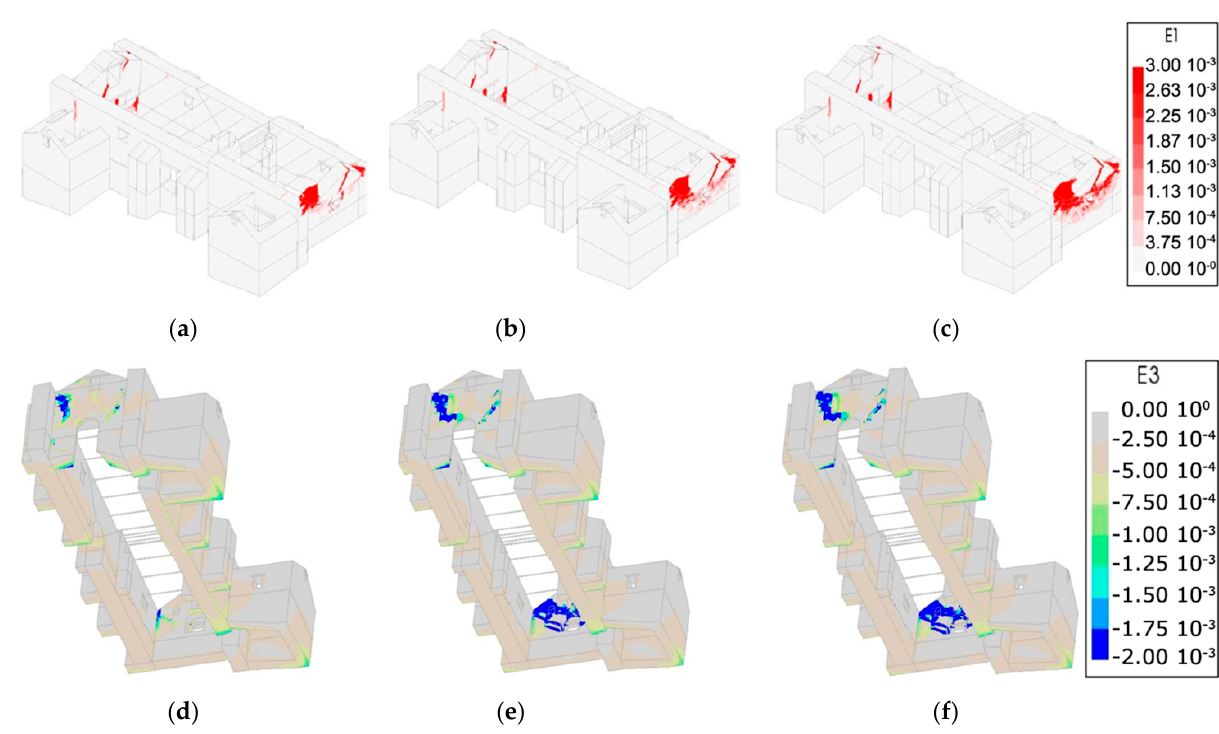
Figure 23. Distribution maximum principal strain in +XX direction at the ultimate stage of ( a ) NTC 2018, ( b ) KADET 2021 and ( c ) ASCE41-13. Distribution minimum principal strain in +XX direction at the ultimate stage of ( d ) NTC 2018, ( e ) KADET 2021 and ( f ) ASCE41-13.